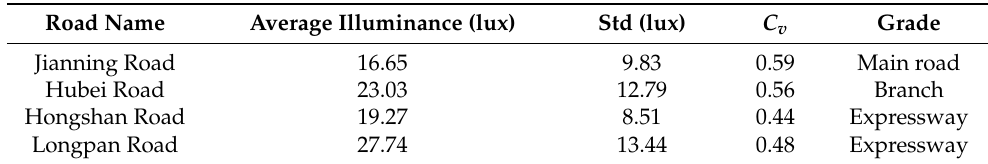
Table 7. Values of typical roads’ lighting quality evaluation